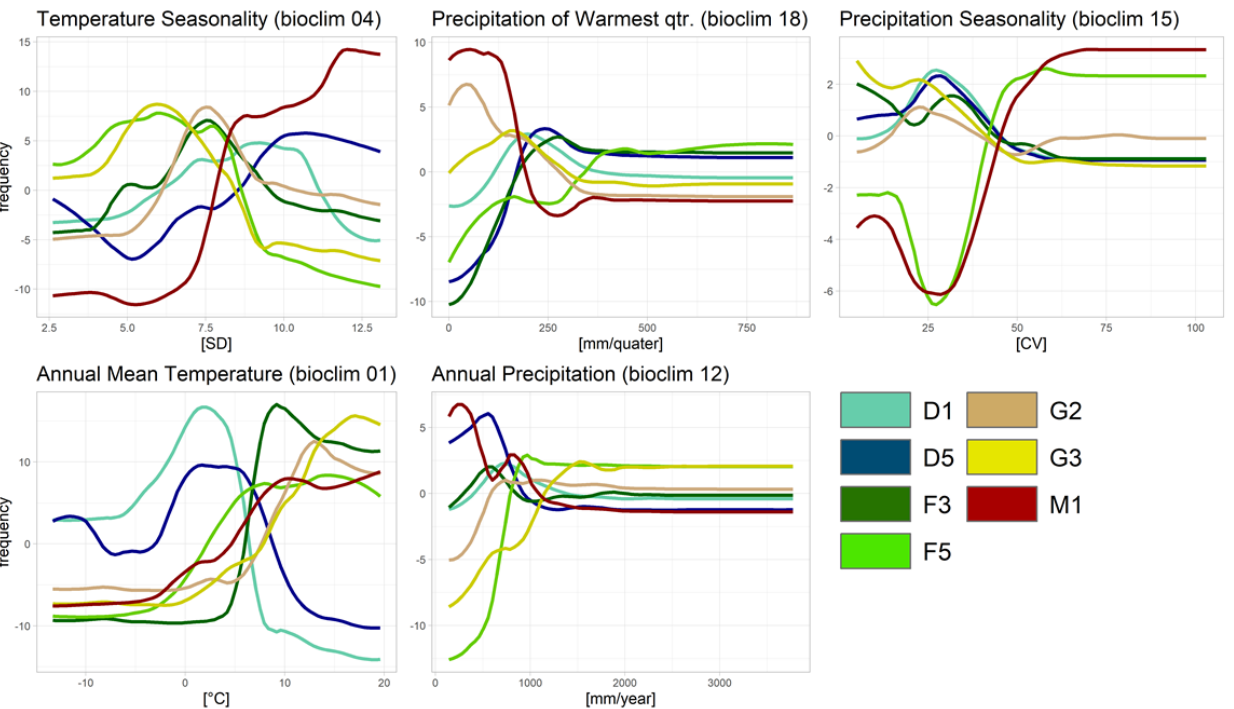
Figure 6. Partial dependence plots of the random forest model for prevalent CaPV classes: Western boreal Picea forests (D1) ‘petrol lines’; boreal and hemiboreal Pinus forests (D5) ‘dark-blue lines’; Mixed Quercus-Carpinus forests (F3) ‘dark-green lines’; Fagus and mixed Fagus forests (F5) ‘bright- green lines’; sub-Mediterranean-subcontinental thermophilous Q. cerris and Q. frainetto forests (G2) ‘light-brown lines’; sub-Mediterranean and meso-supra-Mediterranean Q. pubescens forests (G3) ‘yellow lines’ and true steppes (M1) ‘dark-red